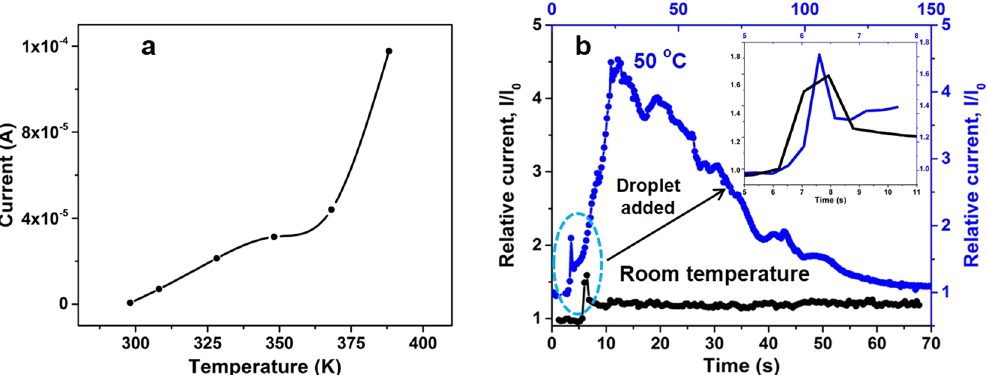
Figure 4. The temperature sensing ability of the device due to its ZnO structure. ( a ) The current across the device at a constant bias of 0.5 V under a base pressure increases monotonically within the temperature range of 298–400 K, as relevant for human skin. ( b ) The device is able to differentiate between two 10 µ l size droplets of 298 and 323 K that are dropped on its surface. An initial fast and nearly identical response due to the pressure from the weight of the droplets is observed in both cases. The inset shows a magnified view of this initial response. For the droplet at 323 K a subsequent slow increase in current is observed due to the propagation of the temperature stimuli. After reaching a peak in current a slow decay over ~60 s due to cooling of the droplet is